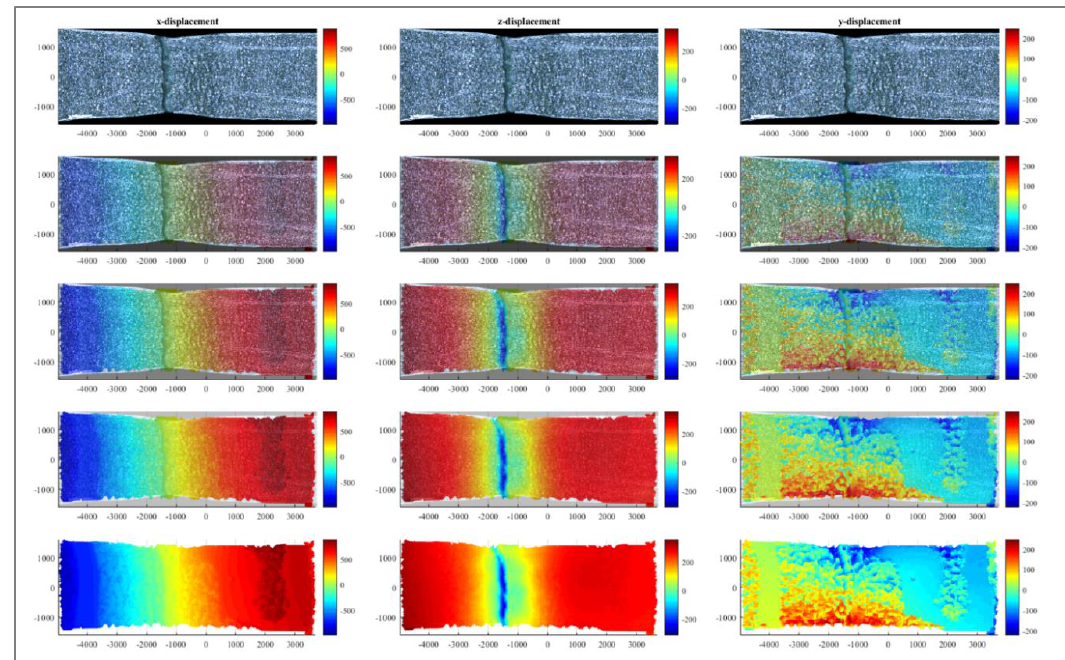
Figure 6. Illustration of the hDIC sub-pixel level displacement calculations in the deformed ROI and their transition from microscopy image of the deformed tensile test specimen in units of micron.